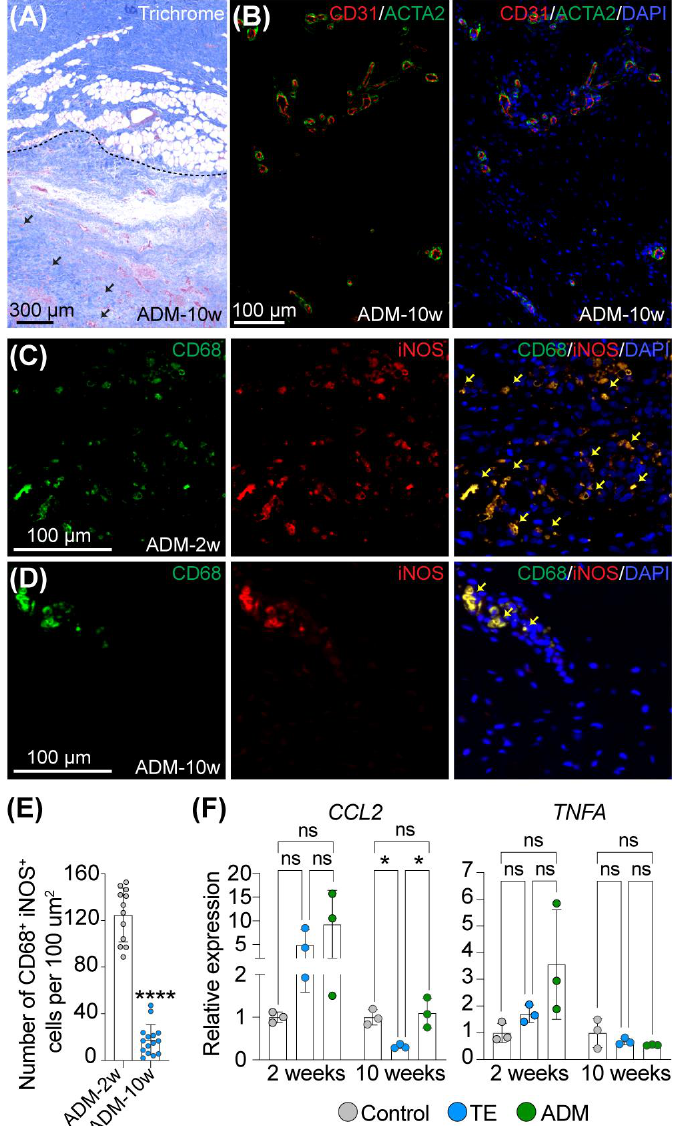
Figure 1. Macrophages are temporally recruited to participate in incorporation of the biological cover into host tissue during expansion. Representative images of ( A ) Trichrome staining of ADM attached to host tissue and ( B ) double immunofluorescence staining of CD31 and ACTA2 of ADM at 10 weeks of expansion. Dashed line and black arrows in ( A ) mark attachment of ADM to host tissue and cells infiltrating ADM, respectively. ( C , D ) Representative images and ( E ) quantitative analysis of double immunofluorescence staining of CD68 and iNOS of ADM attached to host tissue at ( C ) 2 weeks and ( D ) 10 weeks of expansion. The yellow arrows indicate double positive CD68 + iNOS + cells. In ( A ) slides were counterstained with hematoxylin and in ( B – D ) slides were